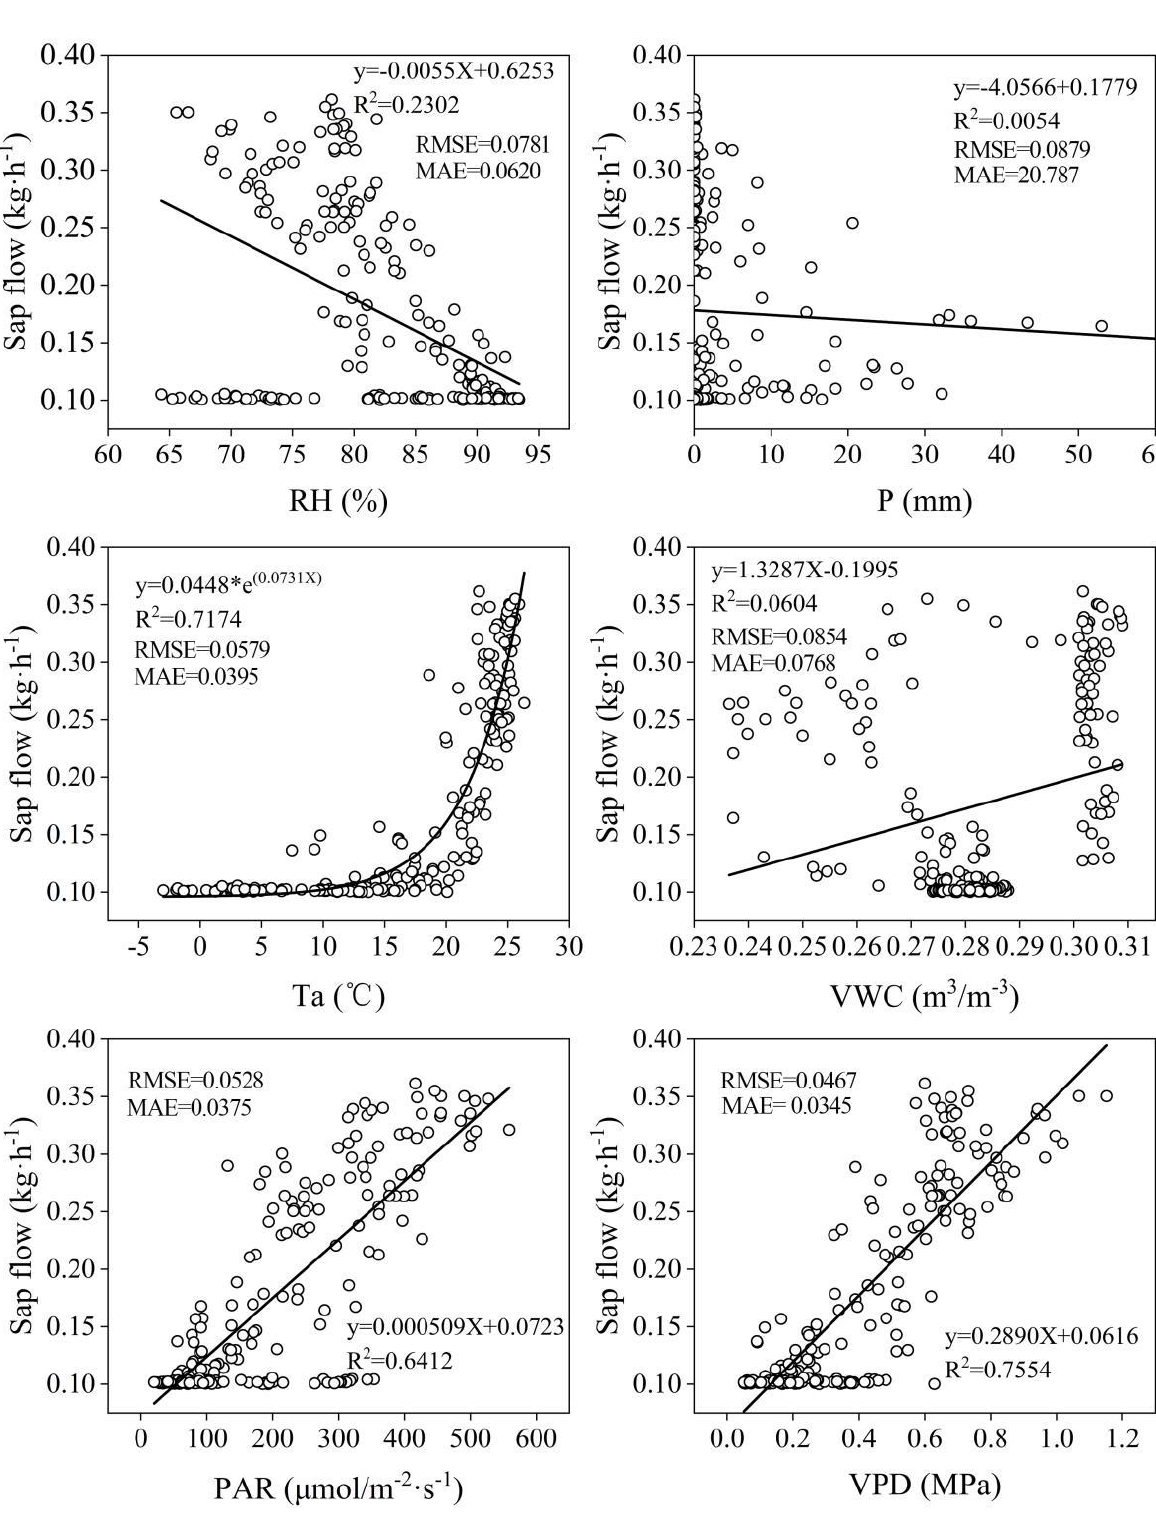
Figure 6. Linear regression analysis and nonlinear analysis of various environmental factors and liquid flow. The black circles in the figure represent each value, and the straight line represents the linearity. From top to bottom are RH: relative humidity; p : precipitation; Ta: air temperature; VWC: volumetric water content; PAR: photosynthetically active radiation; VPD: vapor pressure deficit. RMSE is root mean square error, MAE is mean absolute value error. Significance level p <